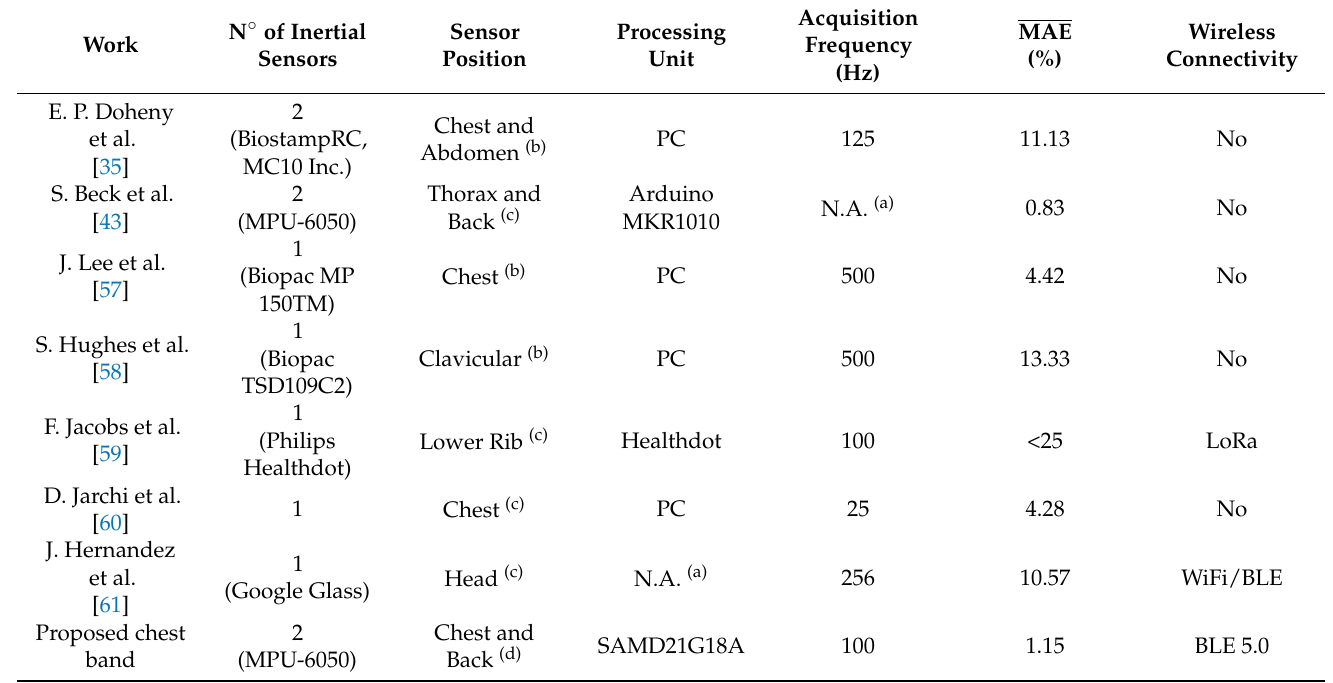
Table 7. Comparison of proposed differential inertial chest band with similar breathing measurement systems reported in the scientific